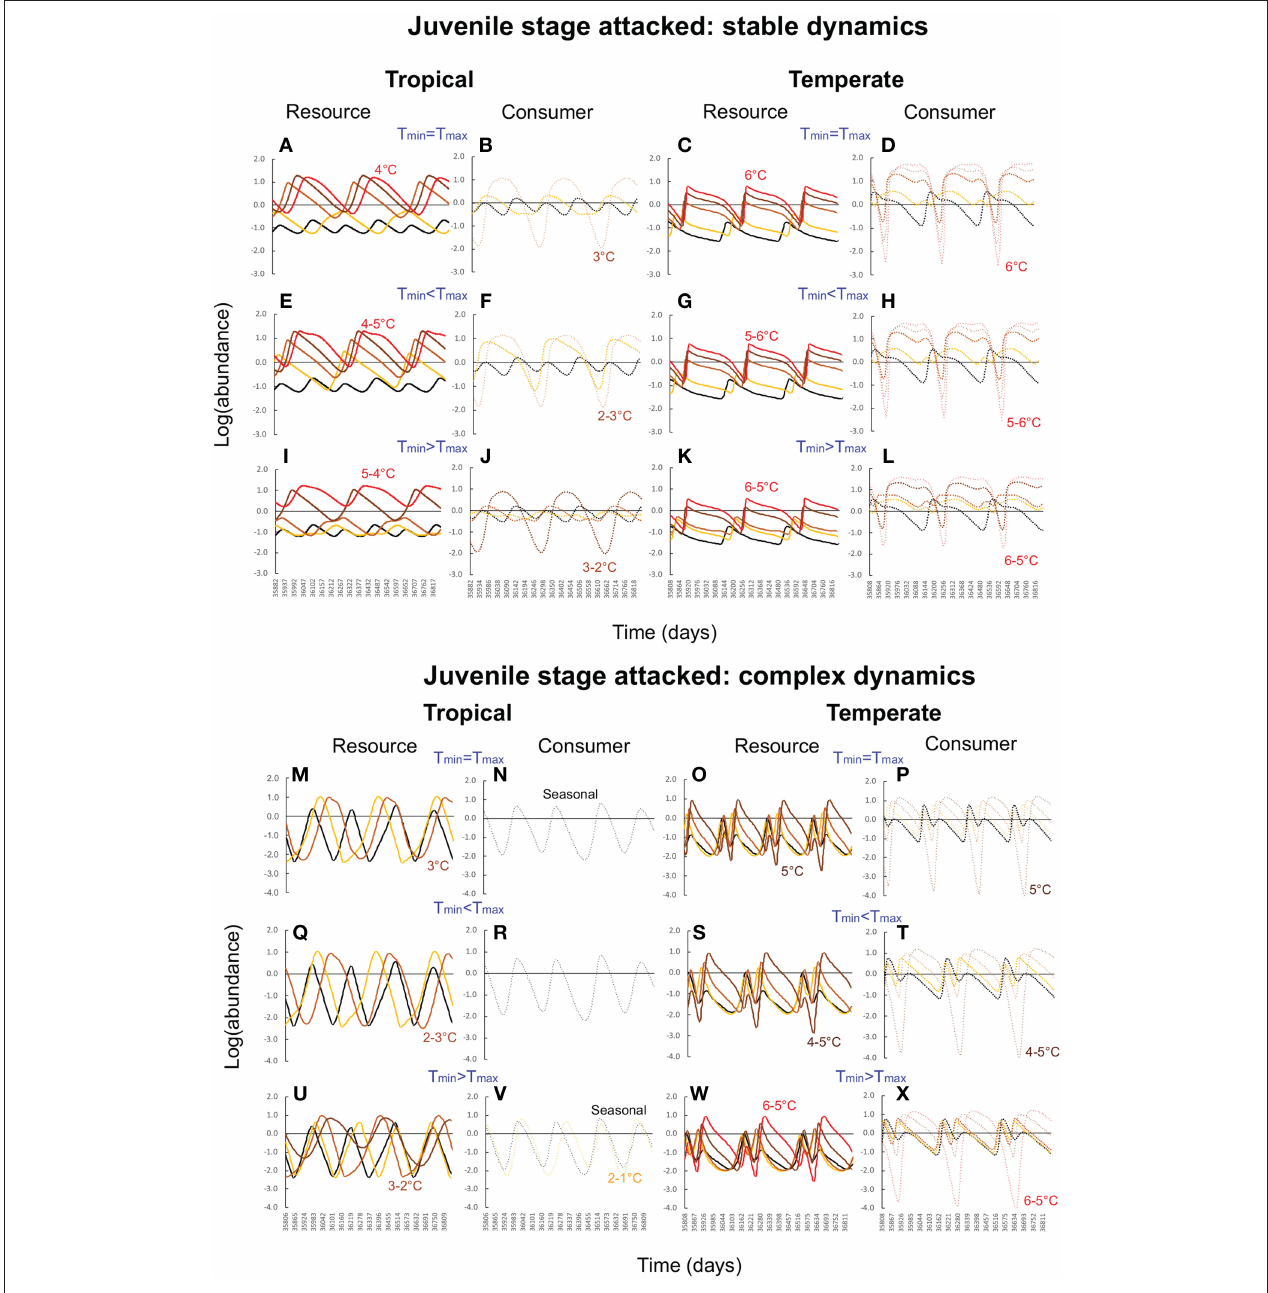
FIGURE 4 | Consumer-resource dynamics in tropical and temperate habitats when when the consumer attacks the juvenile stage and consumer-resource dynamics are stable (A–L) vs. complex (M–X) . In all panels, the black curves (solid for resource, dashed for consumer) depict abundances under typical seasonal variation. Yellow, light brown, dark brown, and red curves depict progressively higher levels of warming (1–4 ◦ C for tropical habitats, 2-6 ◦ C for temperate habitats). For each latitude, the top row of panels depict effects of warming when the minimum and maximum temperatures increase at the same rate (mean increases, amplitude unchanged). The second row depicts warming effects when the maximum temperature increases faster than the minimum (mean and amplitude both increase), and the third row, when the minimum temperature increases faster than the maximum (mean increases, amplitude decreases). Parameter values for the tropical = 2.0, m J = 0.07 ( τ J = 15), d J = 0.05, d A = 0.01, a T = 0.5, d L = 0.1, dP 1 TR = 0.05, m L = 0.1 ( τ L = 10) for stable community are: b T opt opt TR TR TR TR TR TR TR = 2.0, m J = 0.05 ( τ J = 20), d J = 0.05, d A = 0.05, a T = 0.5, d L = 0.1, dP 1 TR = 0.05, m L = 0.1 ( τ L = 10). Parameter values dynamics, and b T opt opt TR TR TR TR TR TR TR = 0.05, m L = 0.1 ( τ J = 10) for stable = 0.01, d L = 0.1, d C = 2.0, m J = 0.04 ( τ J = 25), d J = 0.1, d C for the temperate community are: b T opt T R T R T R T R T R T R TR TR = 0.05, m L = 0.07 ( τ J = 15) for complex dynamics. Other = 1.0, m J = 0.05 ( τ J = 20), d J = 0.05, d R = 0.05, d L = 0.1, d C dynamics and b T opt TR TR TR TR TR TR TR T R parameter values are as in Table 1